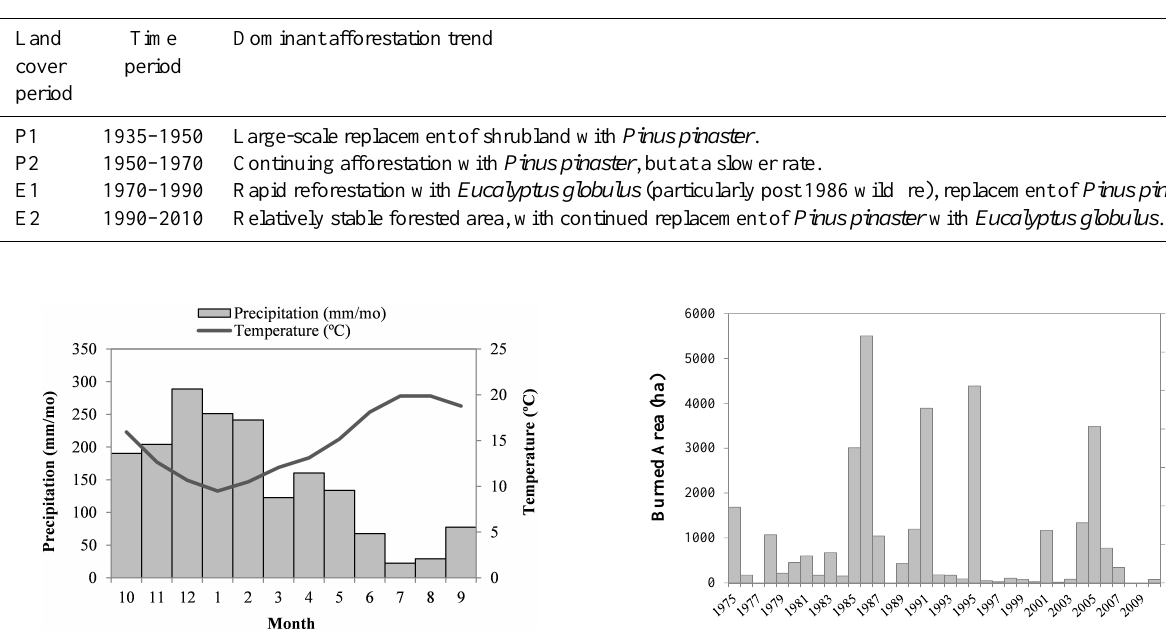
Table 1. Land cover periods and dominant afforestation trends in Águeda watershed from 1935 to 2010.